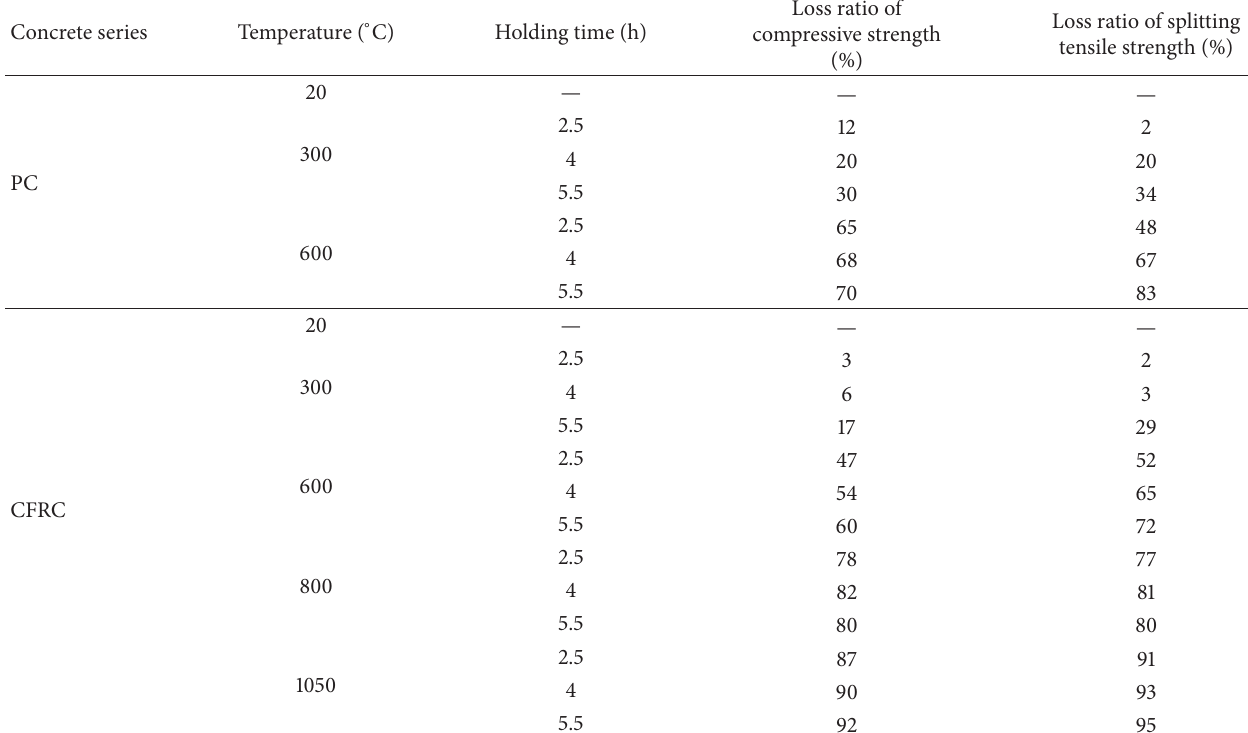
Table 5: Influence of high temperature on mechanical properties of